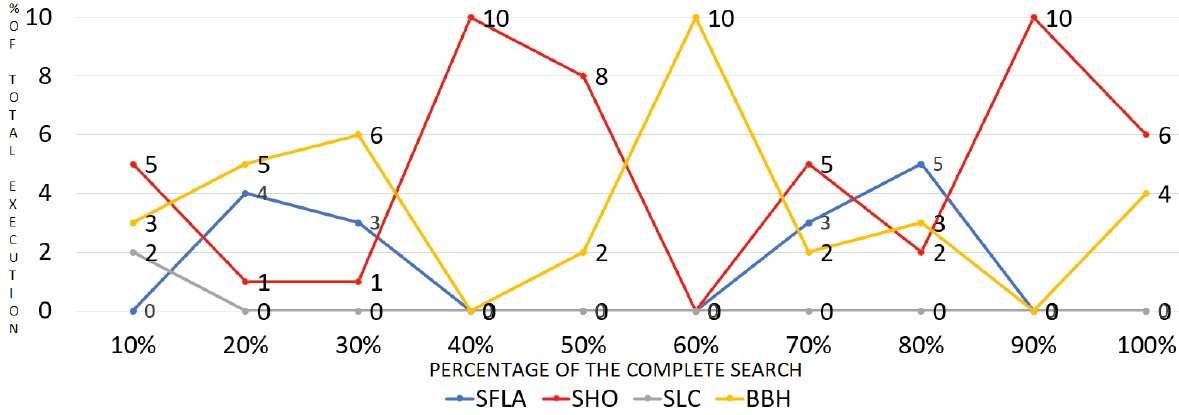
Figure 6. Collaboration evolution for each algorithm. To show the different convergence rates of each algorithm and the DT version, Figure 7 plots the evolution of the minimums found in each iteration, for each algorithm, for one of the solved instances. The rest of the instances presented the same behavior, with small differences of low significance.